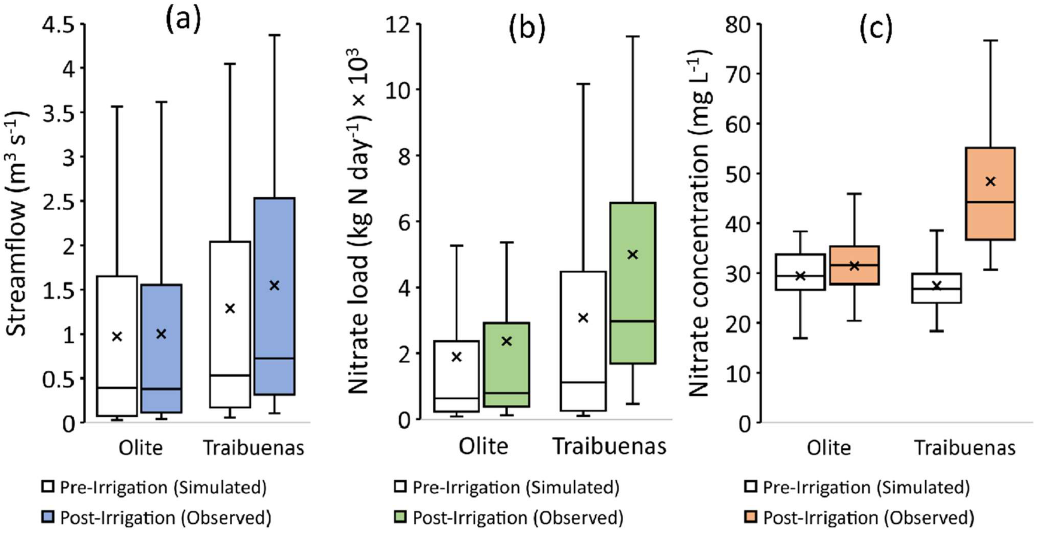
Figure 6. Comparison of average annual changes in ( a ) streamflow, ( b ) nitrate load, and ( c ) nitrate concentration before and after irrigation at Olite and Traibuenas stations from mid-2017 to 2020.